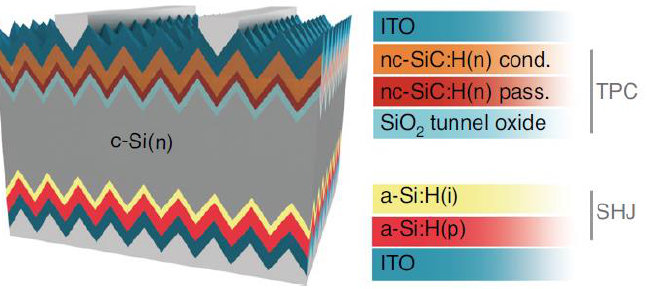
Figure 11. Schematic structure of a highly transparent passivating contact (TPC) provided by the stacked nc-SiC:H(n) window layer [97].